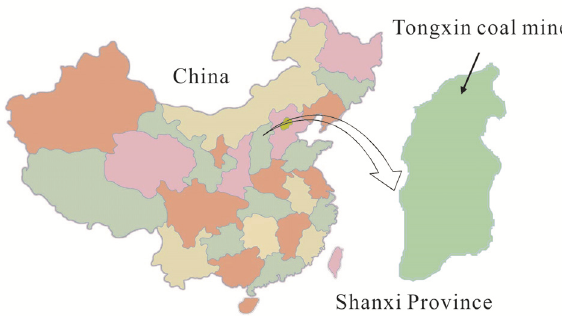
Figure 3: Geographical location of Tongxin coal mine.